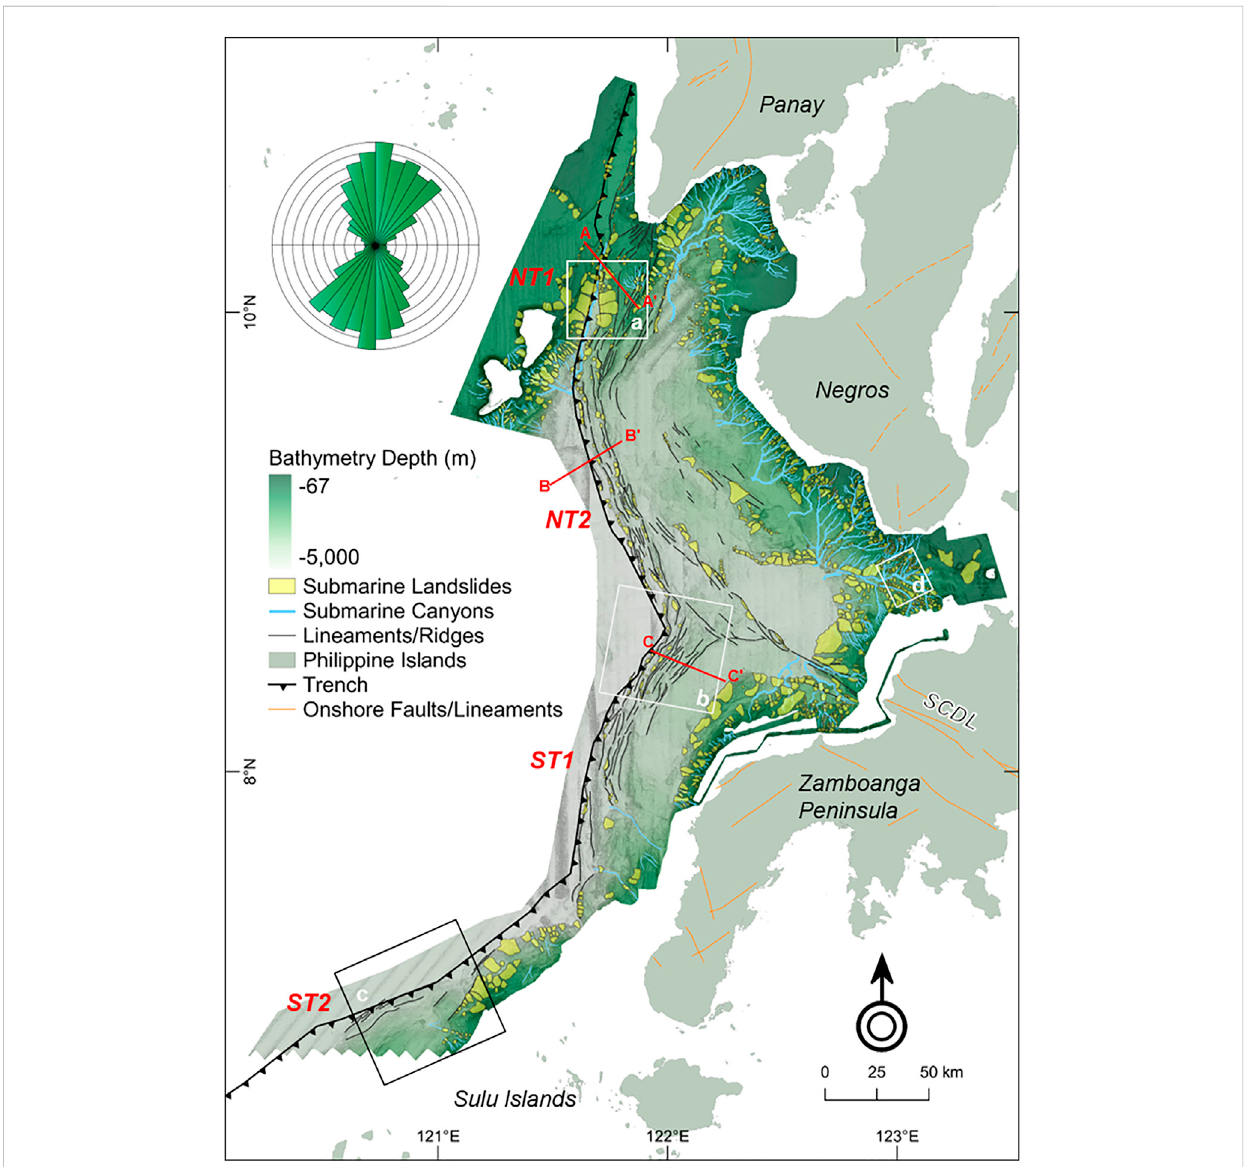
FIGURE 4 Submarine landslides, submarine canyons, and lineaments mapped in the active margin of the NSTS. Rose diagram shows the general northerly trend of the lineaments. Four segments (NT1, NT2, ST1, ST2) were delineated based on the orientation and width variations of the frontal wedge. Squares a – d show the locations of representative submarine features in Figure 5. Red lines are transects of seismic re fl ection pro fi les from Schlüter et al. (1996) (Figure 6). The northwest-trending lineaments mapped offshore of Zamboanga Peninsula are inferred to be an extension of the Sindangan – Cotabato – Daguma Lineament (SCDL) in western Mindanao Island (orange lines = onshore faults/lineaments from